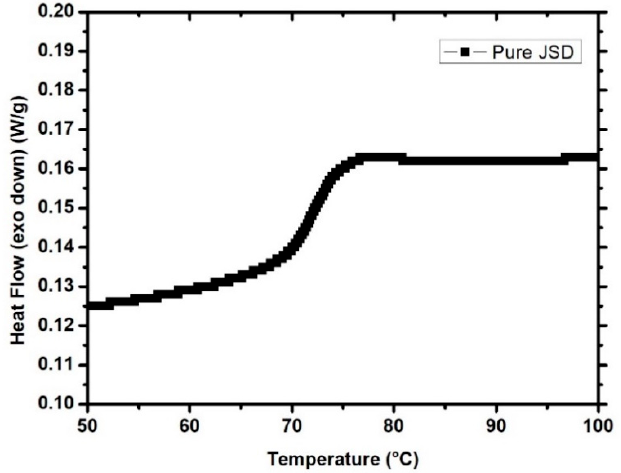
Figure 9. Differential scanning calorimetry ( DSC) run of pure JSD.